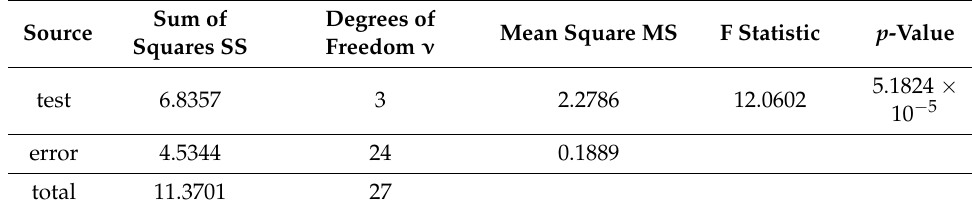
Table 10. Disorientation SSQ score ANOVA summary.